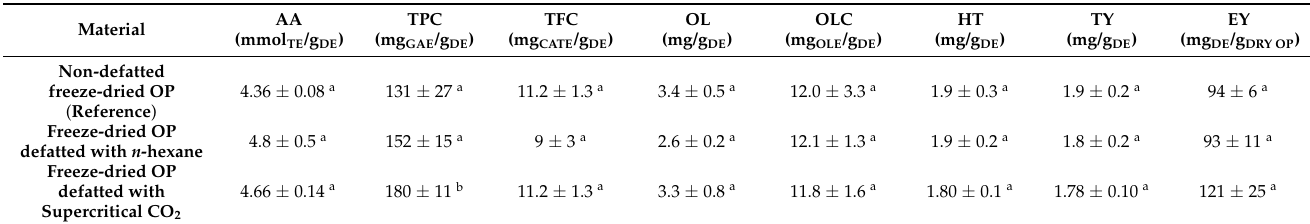
Table 2. Effect of the two defatting pretreatment methods selected on the responses measured for conventional phenolic extracts produced using freeze-dried olive pomace (OP). Values with different lowercase letters in the same column are significantly different ( p <